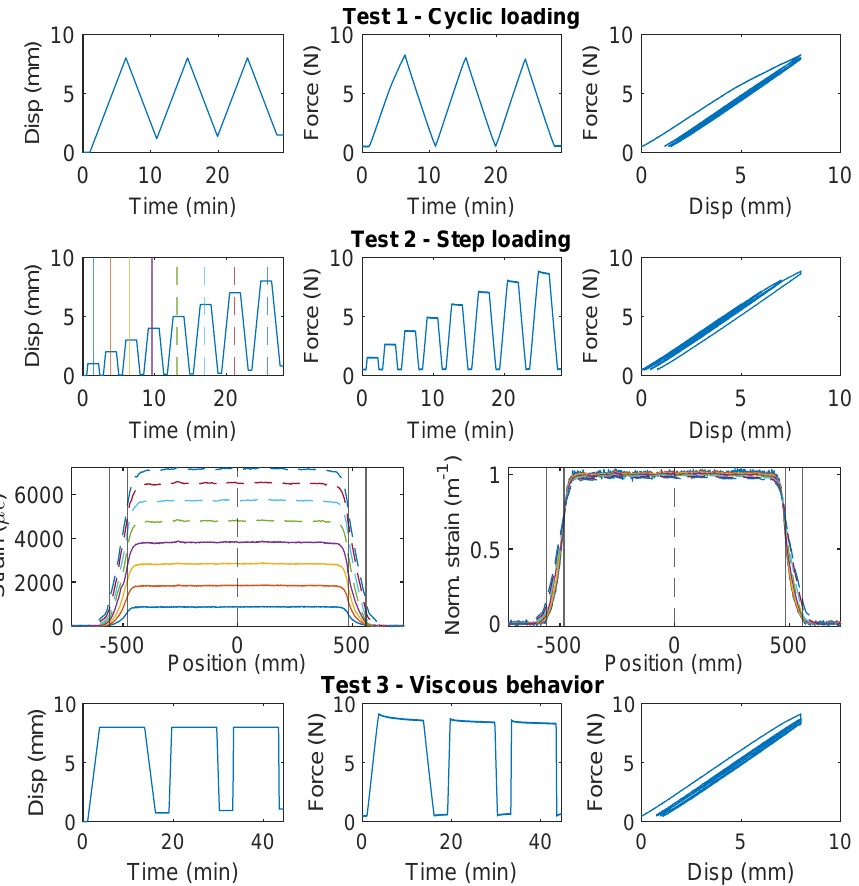
Figure 7. The loading protocol, force–displacement relation, and strain distributions under increasing displacement levels (represented by different color lines) for Specimen 1 of the PFA-Silicone 0.9 mm